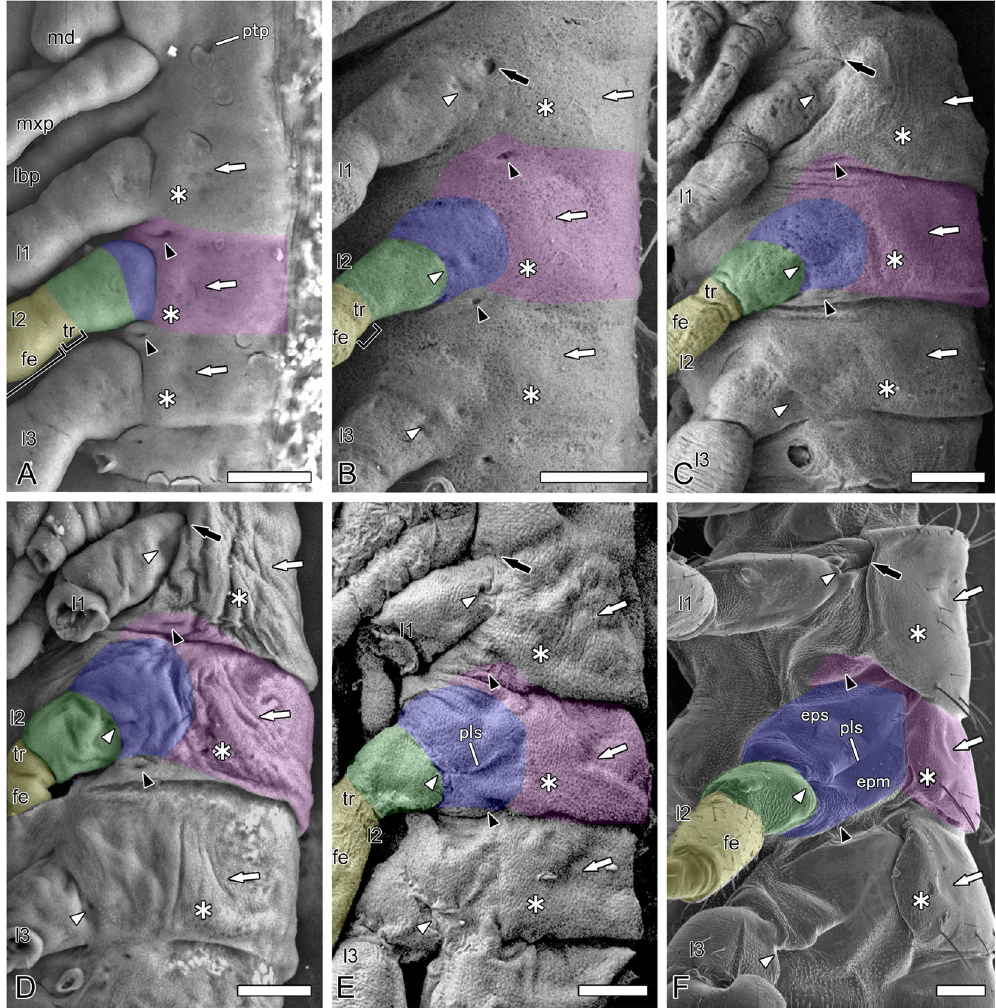
Figure 3. Low-vacuum SEMs of Gryllus bimaculatus embryos and SEM of nymph using the nano-suit method, lateral views. ( A ) Stage 10. ( B ) Stage 11. ( C ) Stage 12. ( D ) Stage 13. ( E ) Stage 14. ( F ) First instar nymph. Abbreviations: fe, femur; lbp, labial palp; l1-3, pro-, meso- and metalimbs; md, mandible; mxp, maxillary palp; pls, pleural suture; pta, posterior tentorial pit; tr, trochanter. Color highlights: dark blue, subcoxa; green, coxa; magenta, tergum; yellow, telopodite. Black arrowheads, black arrows, white arrowheads, white arrows, and asterisks show spiracles, the structure in the prothorax serially homologous to spiracles (see text), pleuro-coxal joints, paratergal grooves, and paratergal bulges, respectively. Bars: 100 µ